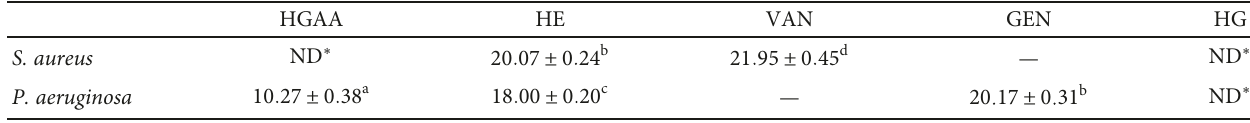
ND ∗ stands for “ not detectable ” ; variables with the same letter means p > 0 05 ; variables having di ff erent letters means p < 0 05 .